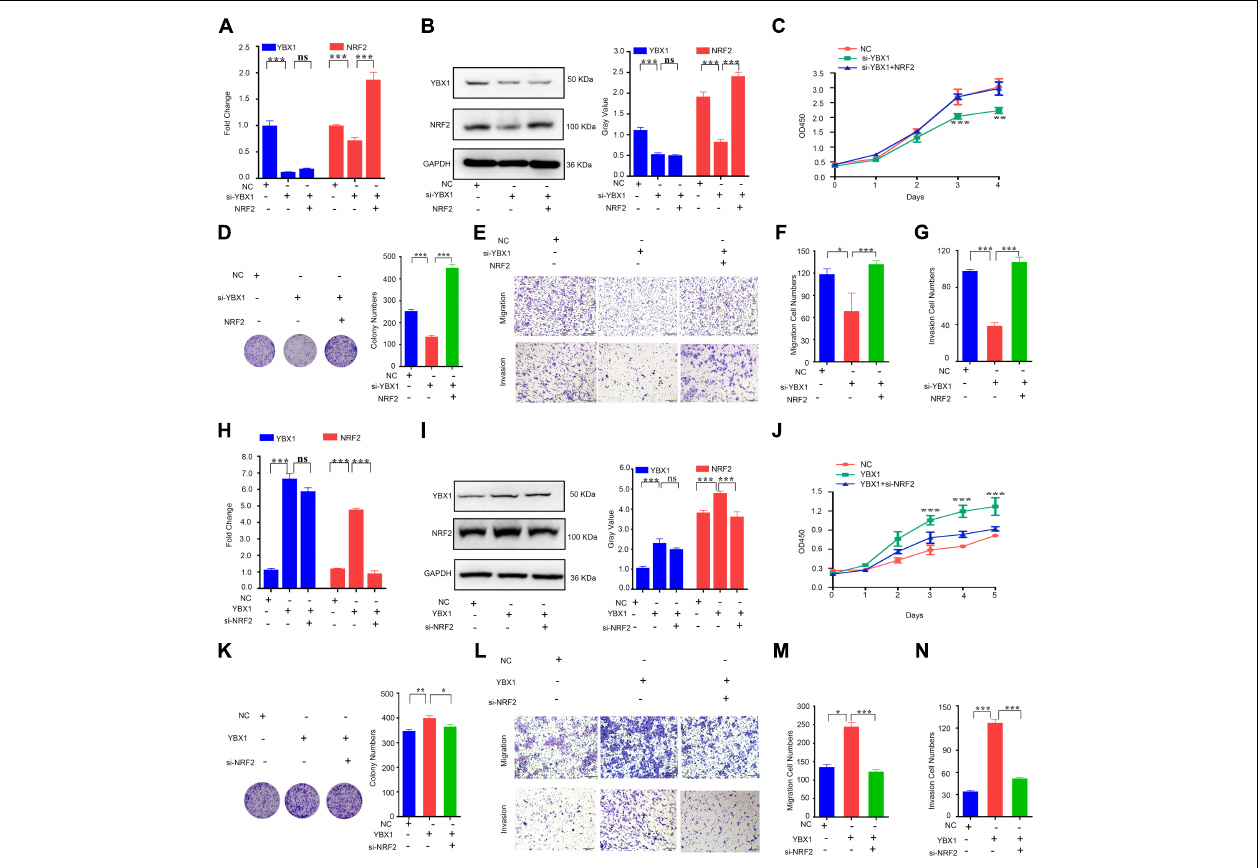
FIGURE 5 | YBX1 is responsible for upregulation of NRF2 expression and CRC proliferation and migration. (A) The YBX1 and NRF2 mRNA expression level were identified by qRT-PCR after downregulation of YBX1 and simultaneous overexpression of NRF2. (B) The YBX1 and NRF2 protein expression level were identified via western blotting after downregulation of YBX1 and simultaneous overexpression of NRF2 (Left). Statistical analysis of western blotting (Right). (C) CCK8 assays were performed to detect cell proliferation after downregulation of YBX1 but an increase in NRF2 expression. (D) Colony formation assays were performed after downregulation of YBX1 but an increase in NRF2 expression (Left). Statistical analysis of the colony numbers (Right). (E) Migration and invasion assays were performed after downregulation of YBX1 but an increase in NRF2 expression. (F) Statistical analysis of the migration cell numbers. (G) Statistical analysis of the invasion cell numbers. (H) The YBX1 and NRF2 mRNA expression level were identified by qRT-PCR after overexpression of YBX1 and simultaneous downregulation of NRF2. (I) The YBX1 and NRF2 protein expression level were identified via western blotting after overexpression of YBX1 and simultaneous downregulation of NRF2 (Left). Statistical analysis of western blotting (Right). (J) CCK8 assays were performed to detect cell proliferation after overexpression of YBX1 and downregulation of NRF2. (K) Colony formation assays were performed after overexpression of YBX1 and downregulation of NRF2 (Left). Statistical analysis of the colony numbers (Right). (L) Migration and invasion assays were performed after overexpression of YBX1 and downregulation of NRF2. (M) Statistical analysis of the migration cell numbers. (N) Statistical analysis of the invasion cell numbers. * p < 0.05; ** p < 0.01; *** p < 0.001; ns, no